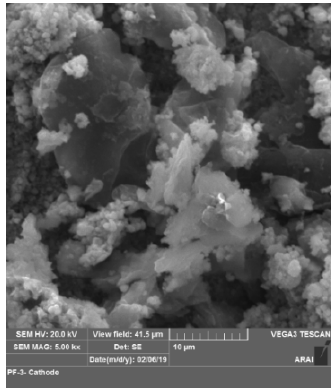
Figure 10. Nail-penetrated cell cathode with location at centre (100% SoC).